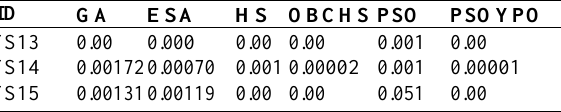
Table 6. Comparison of STD results for LS problems